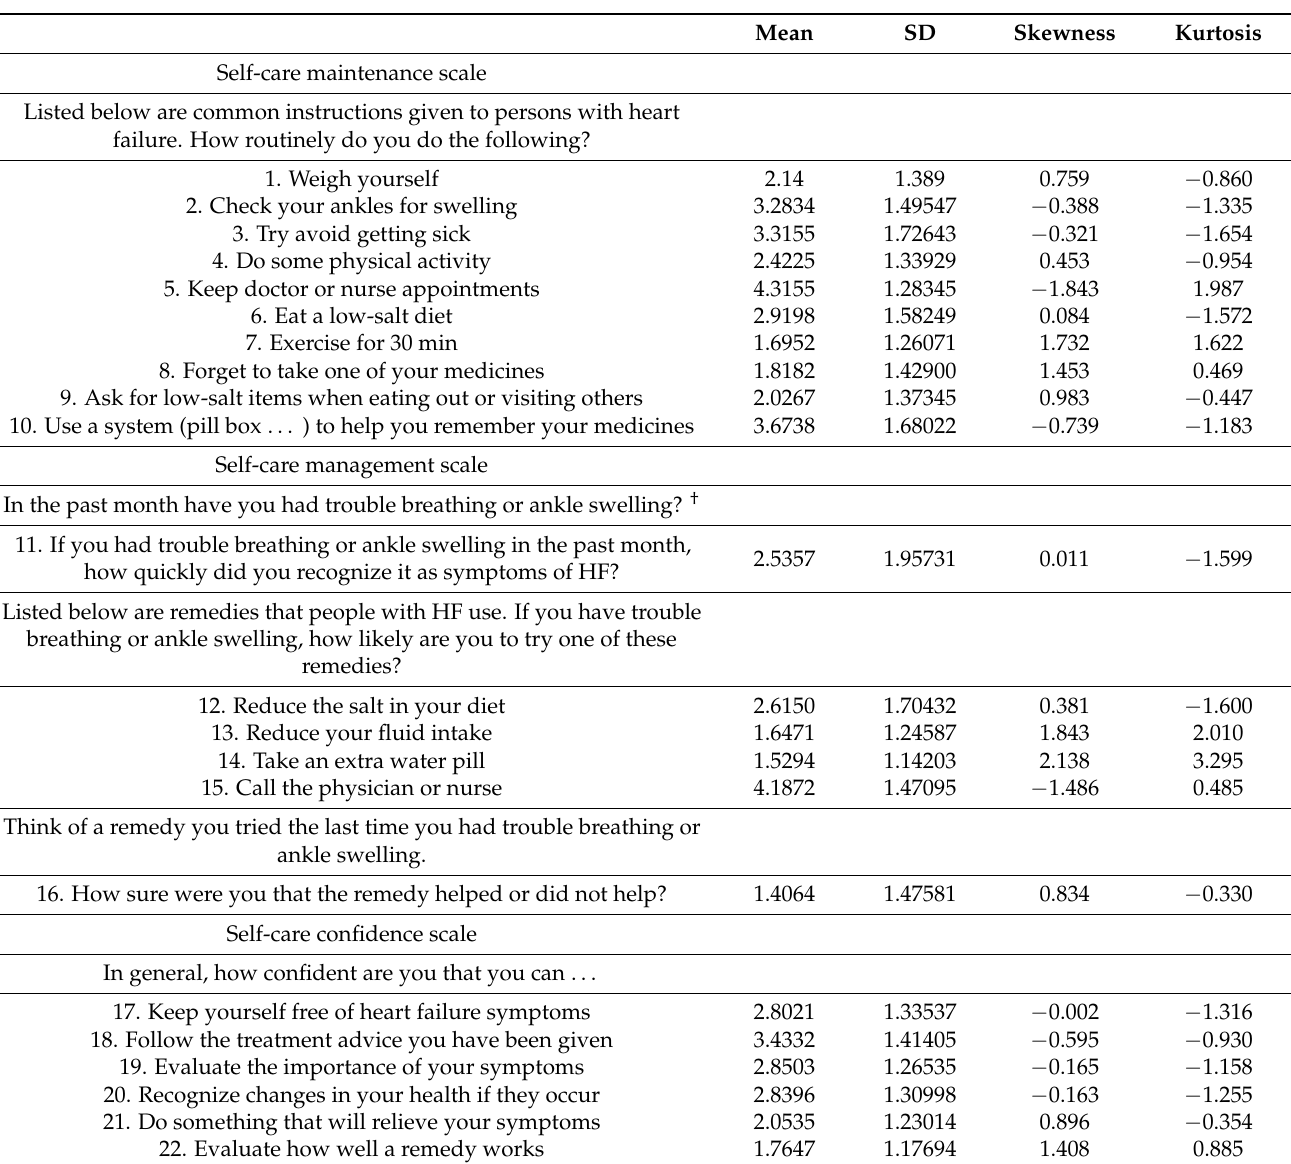
Table 2. Descriptive statistics of the Self Care of Heart Failure Index (SCHFI)